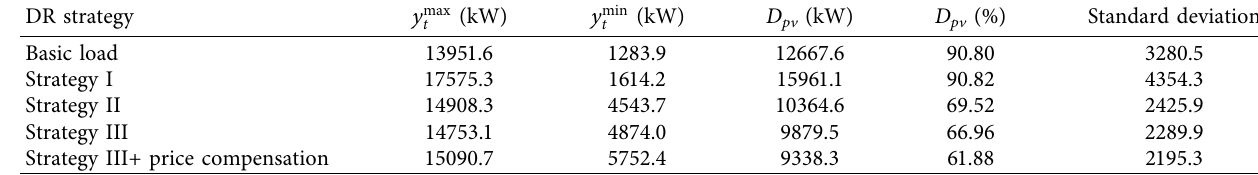
Table 4: Levels of load peak-to-valley diferences and load fuctuation under diferent DR strategies.